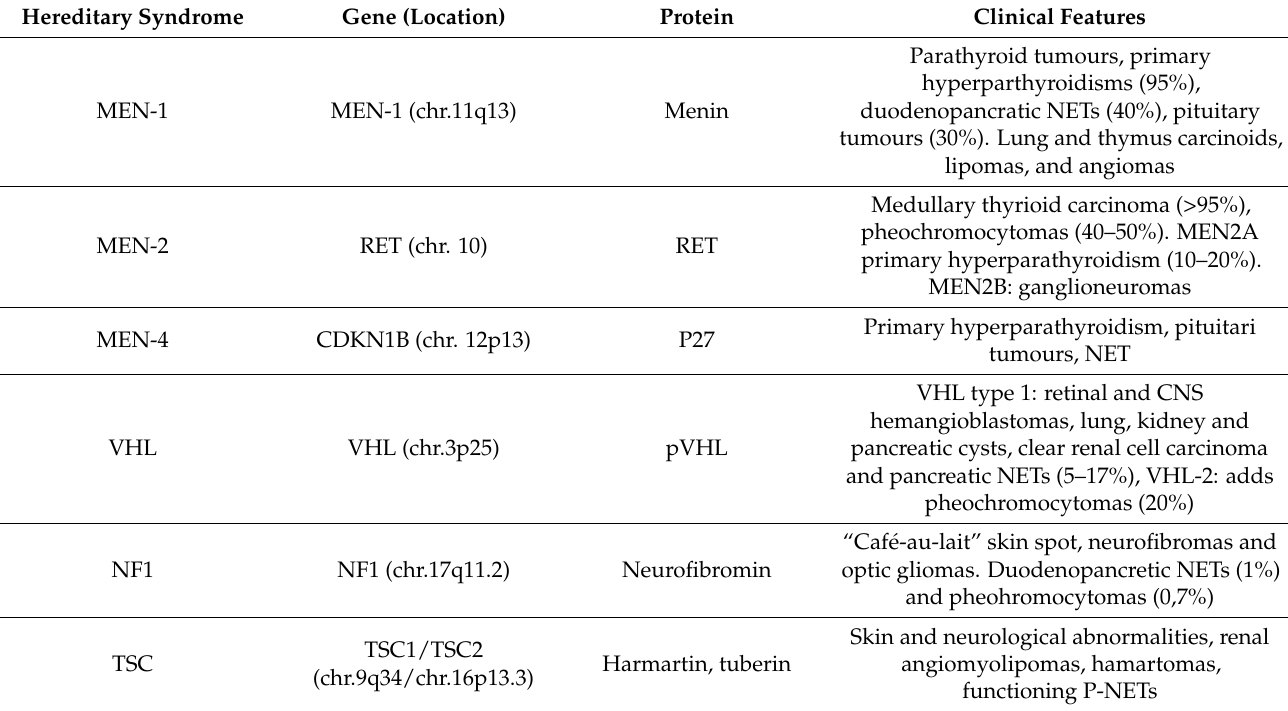
Table 4. Most frequent hereditary syndromes in